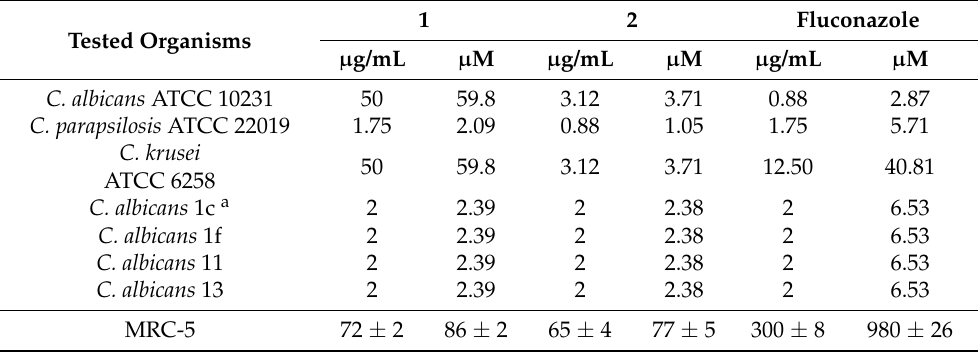
Table 1. Antifungal (MIC) activity of complexes 1 and 2 in comparison to fluconazole on different Candida species and their cytotoxicity against healthy human fibroblasts MRC-5 (IC 50 ). 1 2 Tested Organisms